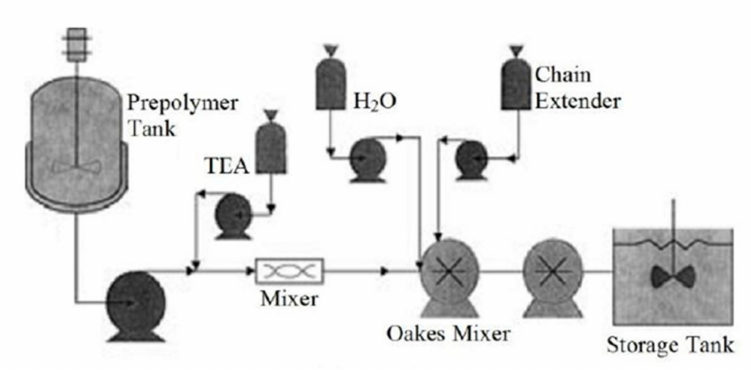
Figure 4. Prepolymer method continuous mixer set-up [33]. Copyright © (2010) John Wiley and Sons